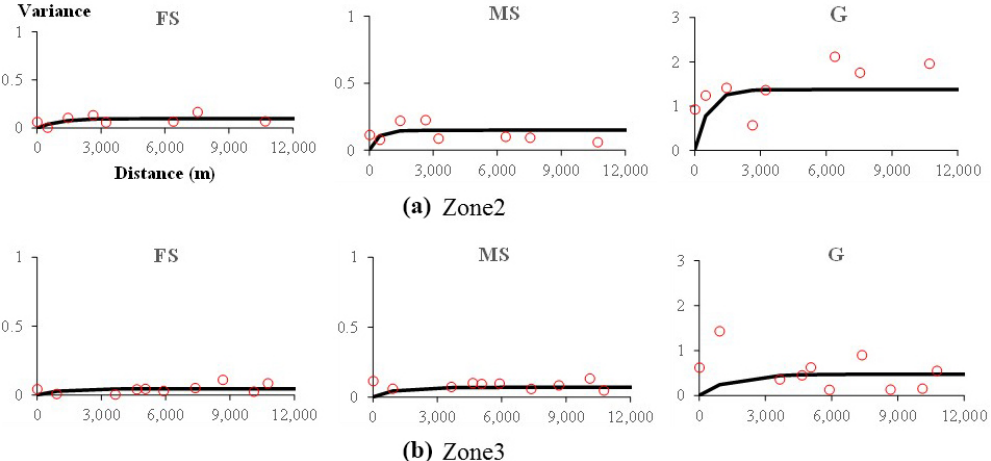
Figure 7. Experimental (circle symbol) and model (solid line) semivariogram along the dip direction for the various hydrofacies in zone 2 and zone 3. Notice that the range in the y axis differs for gravel lithology.